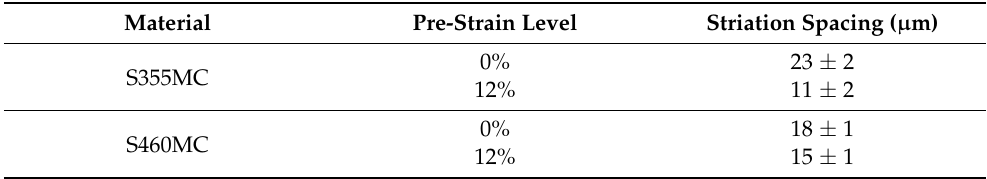
Table 6. Measurement of fatigue striations.